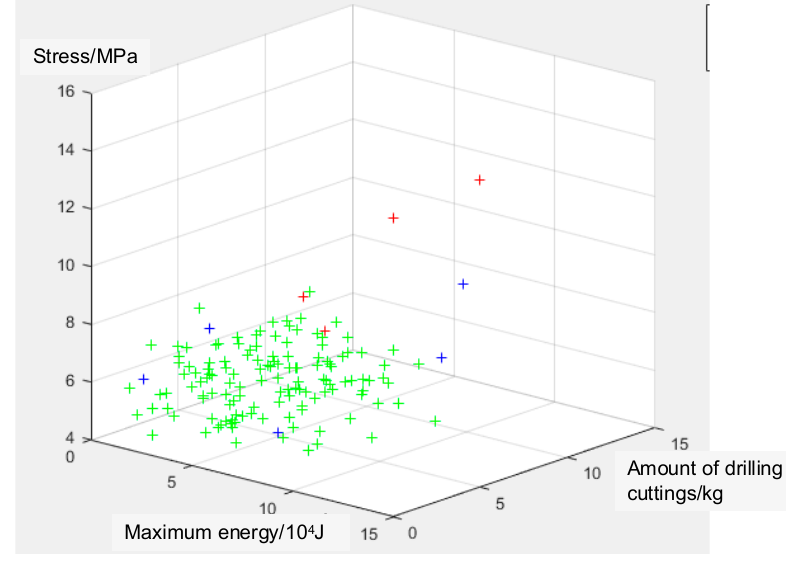
Figure 7. Clustering results of rock burst data. Table 11. Stress online early warning value.